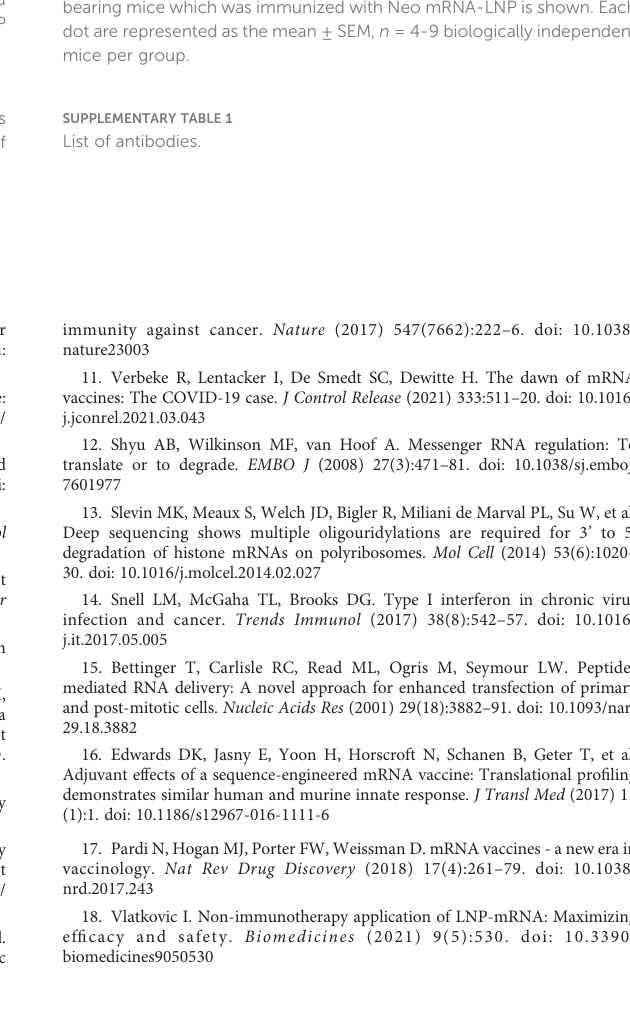
SUPPLEMENTARY FIGURE 11 Effect of immunization of Neo-LNP on body weight changes in tumor bearing mice. Percent of body weight changes of B16F10-Luc2 tumor- bearing mice which was immunized with Neo mRNA-LNP is shown. Each dot are represented as the mean ± SEM, n = 4-9 biologically independent mice per group.